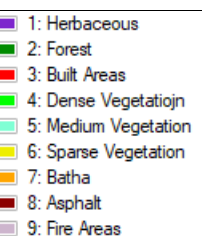
Table 2: Determination coefficients of the linear regression analysis between NDVI and PET accumulated for 1 to 6 months.